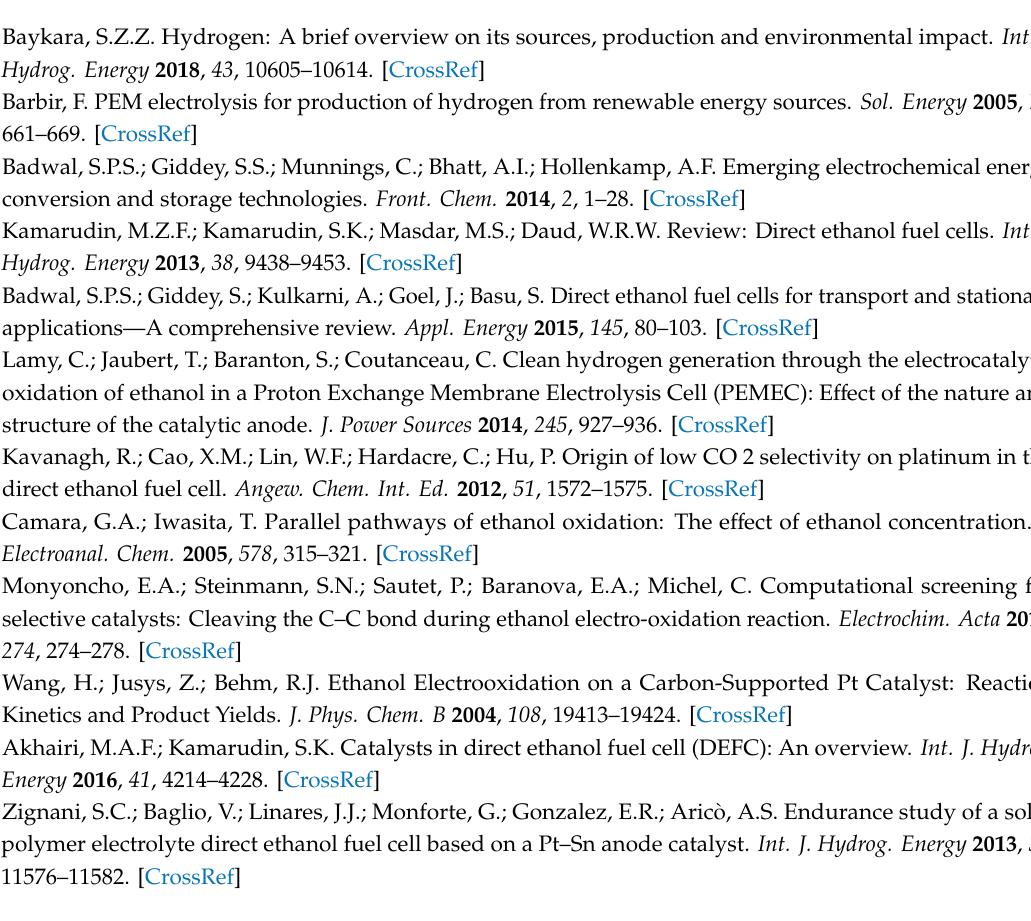
Figure S1: Nanoflake thickness measurement example (sample B), Figure S2: Microsphere diameter measurement example (sample F), Table S1: Peak analysis of X-ray di ff raction data, Figure S3: Cyclic voltammograms of the 1st and 100th cycle of the di ff erent morphologies of Ni(OH) 2 catalysts deposited on a glassy carbon electrode with a loading of ~0.5 mg cm − 2 in a solution of 1 M KOH with 1 M ethanol with a scan rate of 20 mV s − 1 , Figure S4: Cyclic voltammogram of β -Ni(OH) 2 microspheres with nanoflakes (sample C) in the presence and absence of 1 M ethanol in 1 M KOH at 20 mV s − 1 , Figure S5: Extended cyclic voltammogram of α -Ni(OH) 2 microspheres with nanoflakes (sample E) deposited on a glassy carbon electrode with a loading of ~0.5 mg cm − 2 in a solution of 1 M KOH with and without 1 M ethanol with a scan rate of 20 mV s − 1